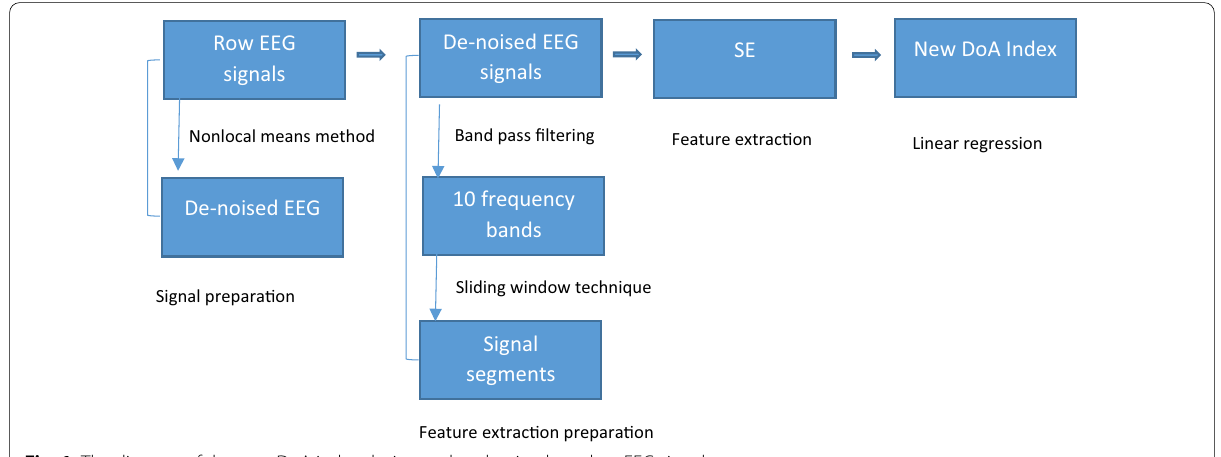
Fig. 1 The diagram of the new DoA index design and evaluation based on EEG